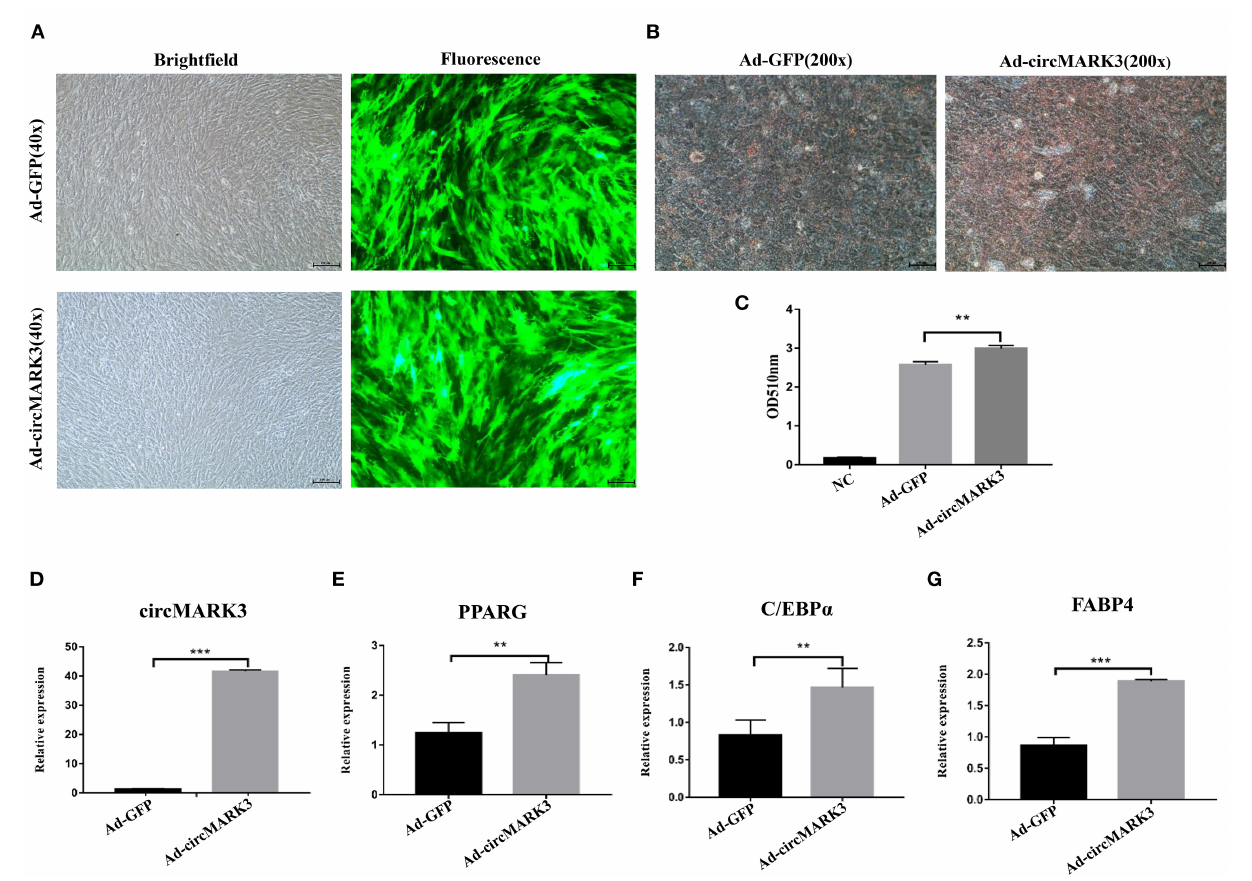
FIGURE 5 | Overexpression of buffalo circMARK3 promotes adipogenic differentiation of buffalo adipocytes. (A) Micrographs of GFP-positive cells in the Ad_GFP and Ad_circMARK3 groups on day 2 after cell transfection; (B) Oil Red O staining of buffalo adipocytes transfected with Ad_GFP and Ad_circMARK3 group on day 6 after adipogenic differentiation. (C) Histogram corresponding to the quantification of Oil Red O staining by spectrophotometry; (D–G) RNA expression two days after transfection of circMARK3 (D) , PPARG (E) , C/EBP α (F) , and FABP 4 (G) . Bovine- GAPDH was used to normalize the expression level of the reference gene in buffalo adipocytes. NC means negative control. Data are presented as the mean ± SD, n = 3, ** P < 0.01, *** P <